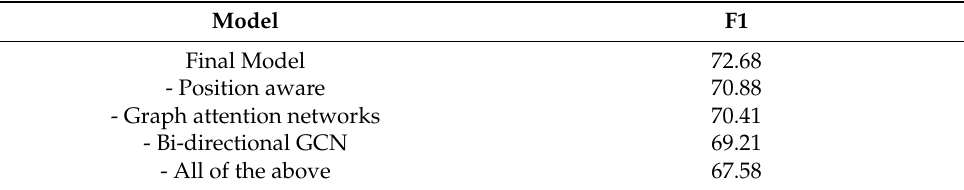
Table 2. Ablation analysis.